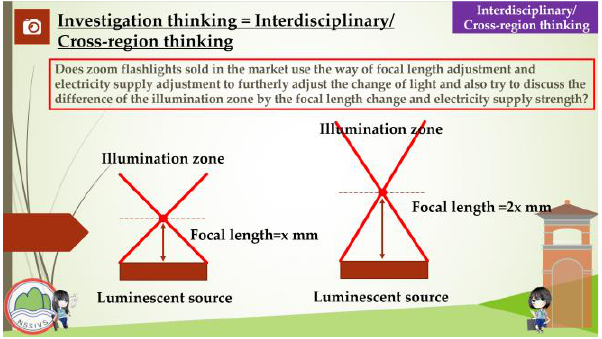
Figure 5. Competency-based instructional materials used in this research. These require interdisci-